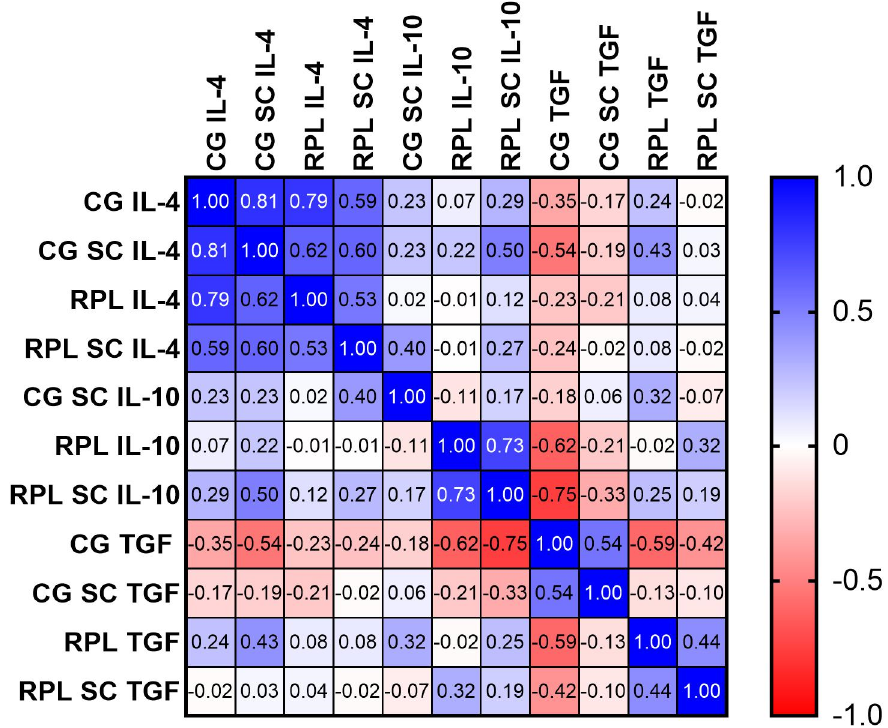
Figure 4. Pearson’s “r” factor correlations between anti-inflammatory cytokines. Blue colors stand for a positive correlation r > 0, red colors r < 0. (CG—control group, n = 20; RPL—study group, n = 21; SC—sildenafil citrate).